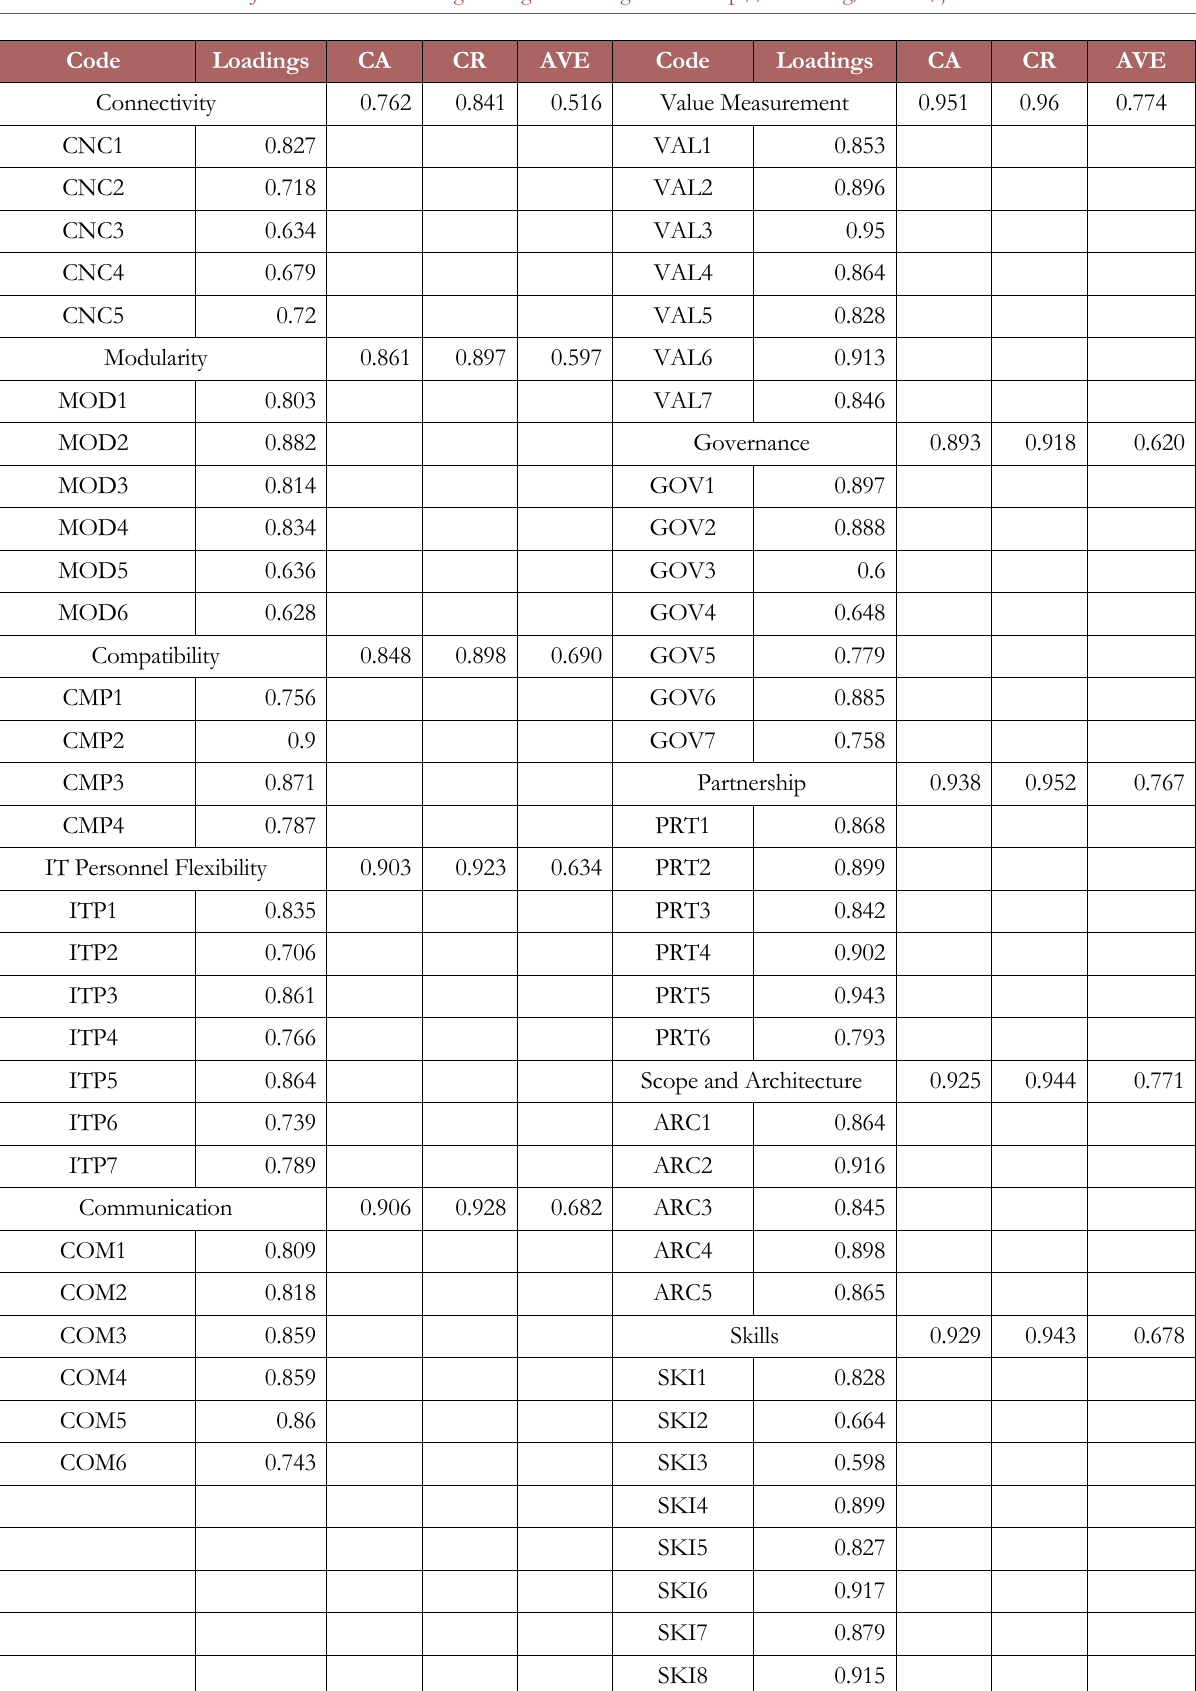
Table 3. Psychometric properties of measurement model (null